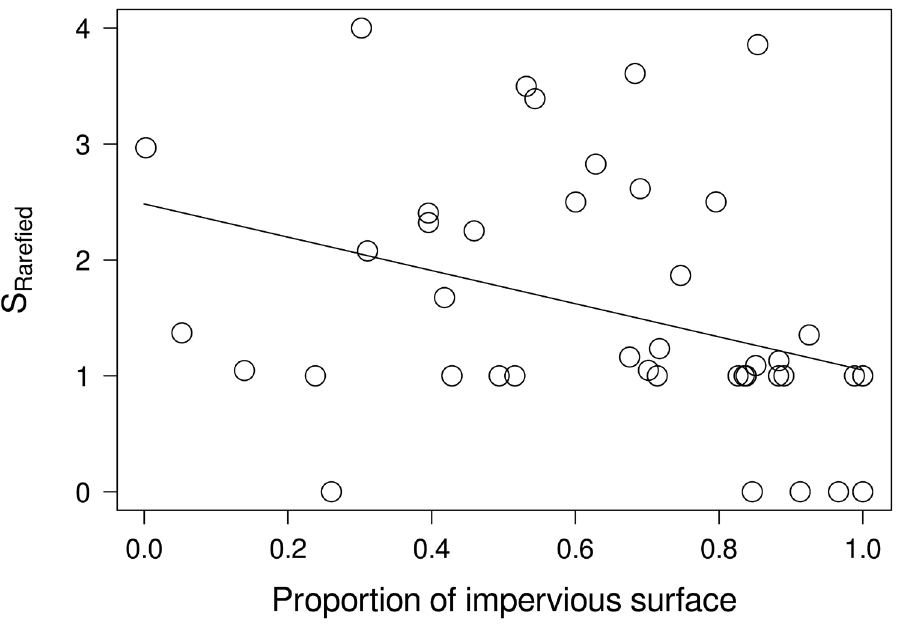
FIGURE 4 | Relationship between rarefied species richness (S The line indicates fitted